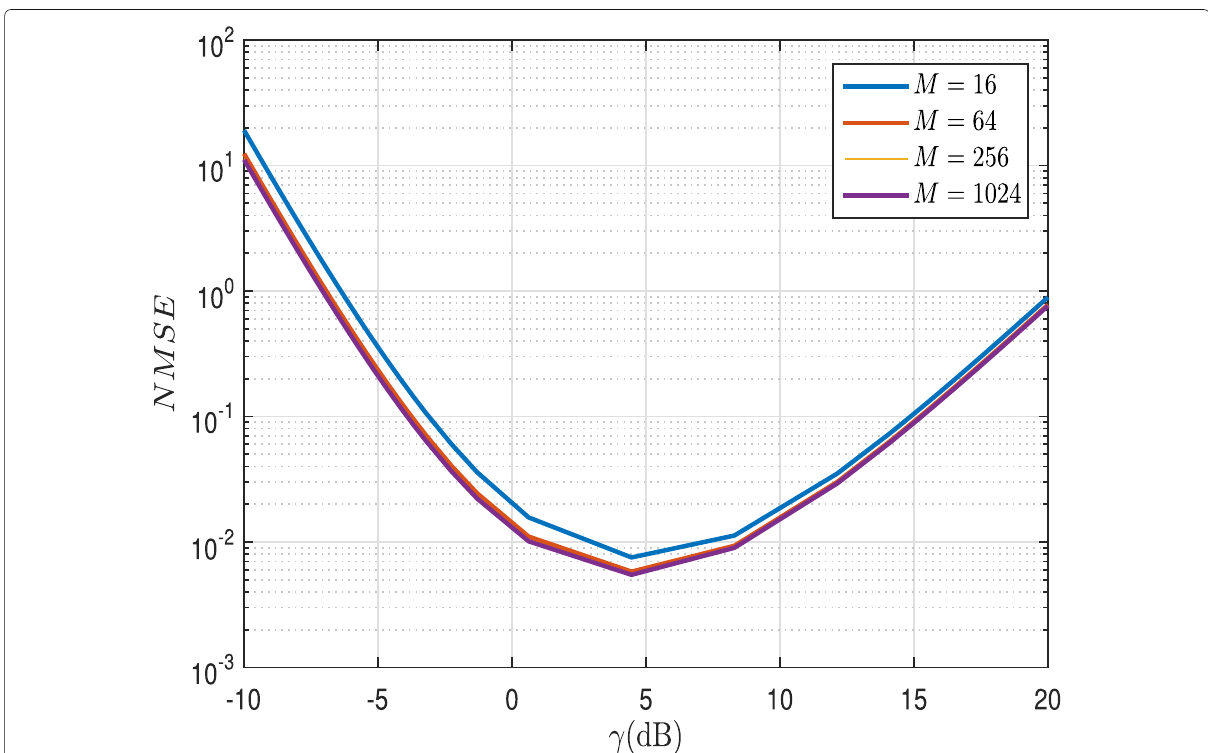
Fig. 10 NMSE of the estimate ˆ γ as a function of the SNR in dB, N = 5 × 10 4 , κ − μ fading for κ = 3 and μ = 0.5, and different orders of the M -QAM